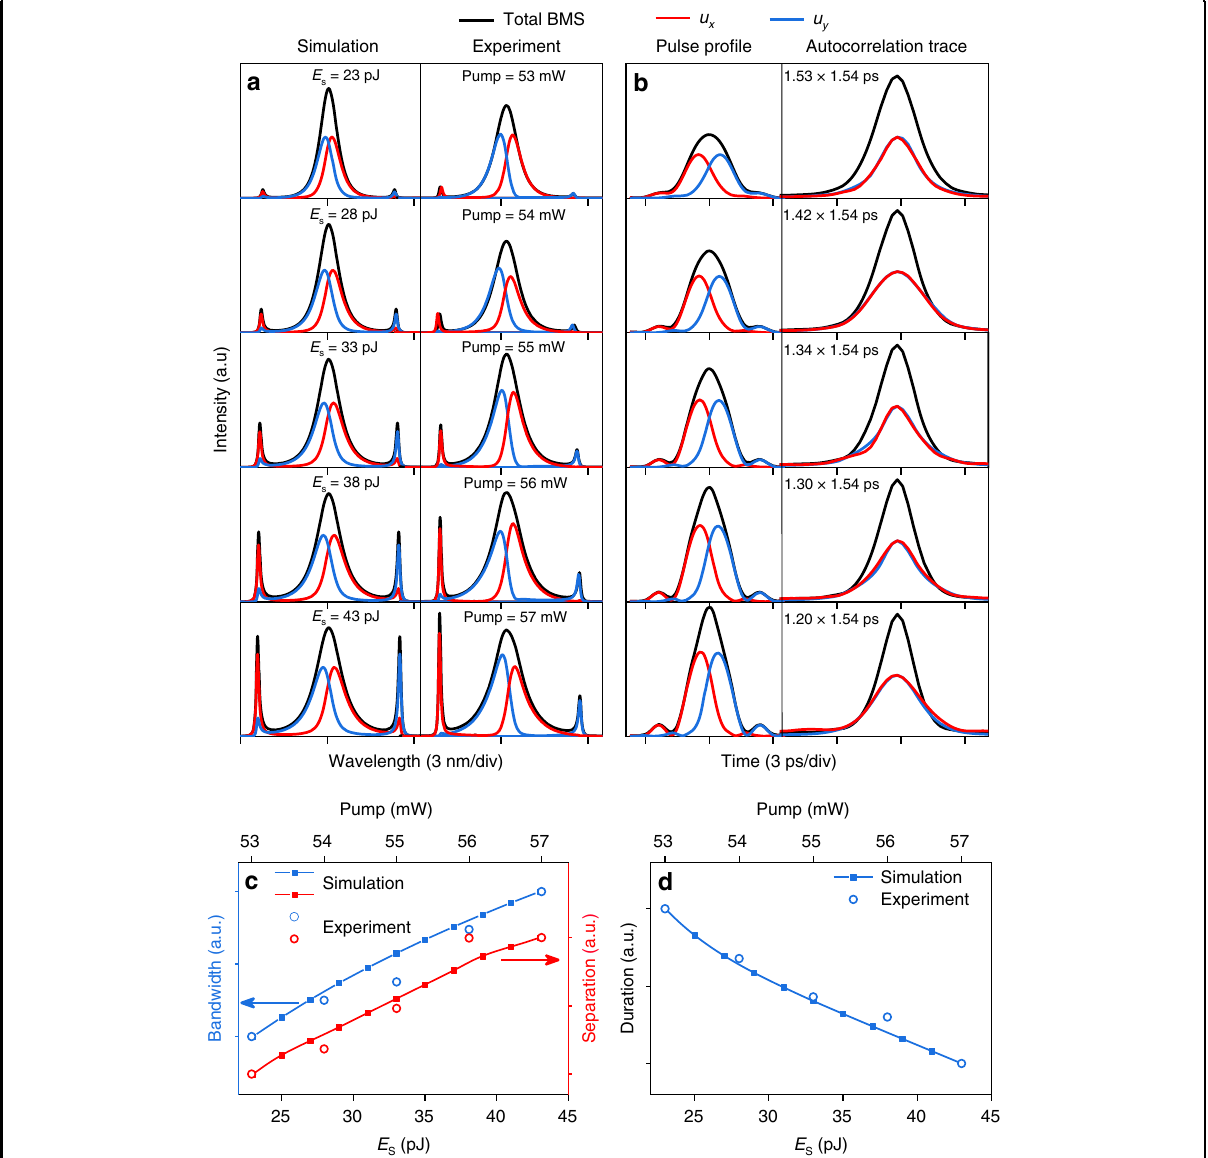
Fig. 2 Evolution of BMS with gain saturation energy ( E s ) and pump power. a Simulated and measured spectra. b Simulated pulse pro fi les and measured autocorrelation traces. c Bandwidth of BMS and sideband separation of u y component versus E s and pump power. d Pulse duration of BMS versus E s and pump